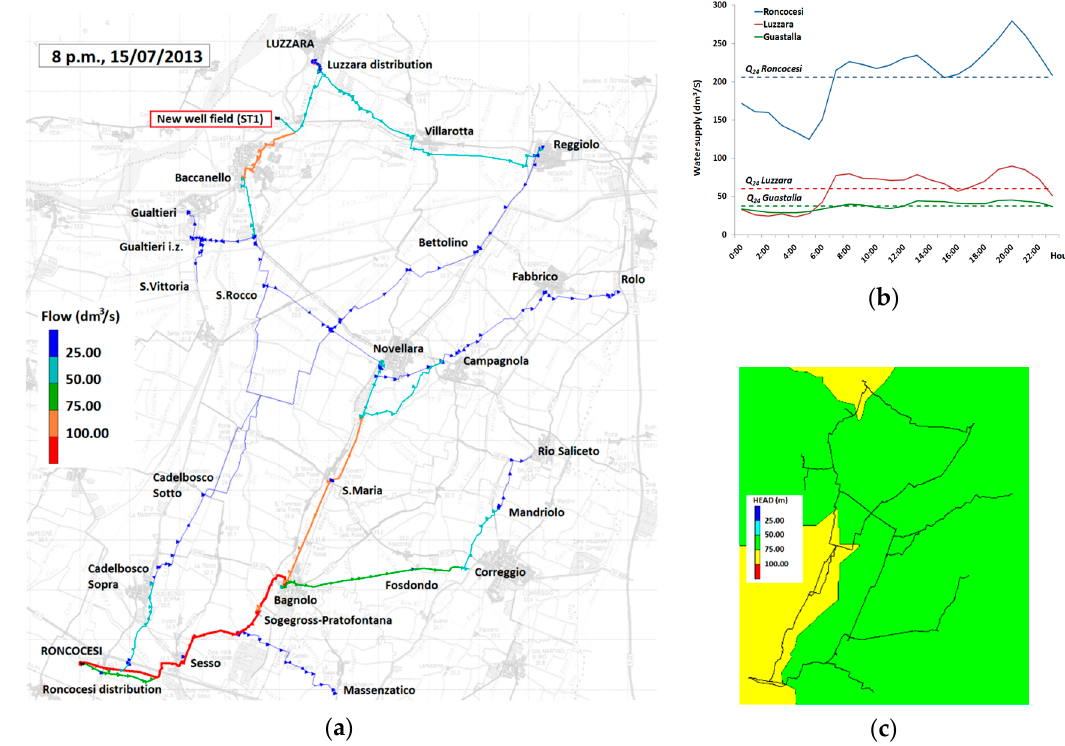
Figure 7. Hydraulic simulations of ST1 over the day of highest consumption (15 July 2013). ( a ) Flows derived at 8 p.m. ( b ) Average hourly water supply (dm 3 /s) introduced in Roncocesi, Luzzara, and Guastalla networks by the main reservoirs; ( c ) Contour plot of the total head over the networks at 8 p.m.